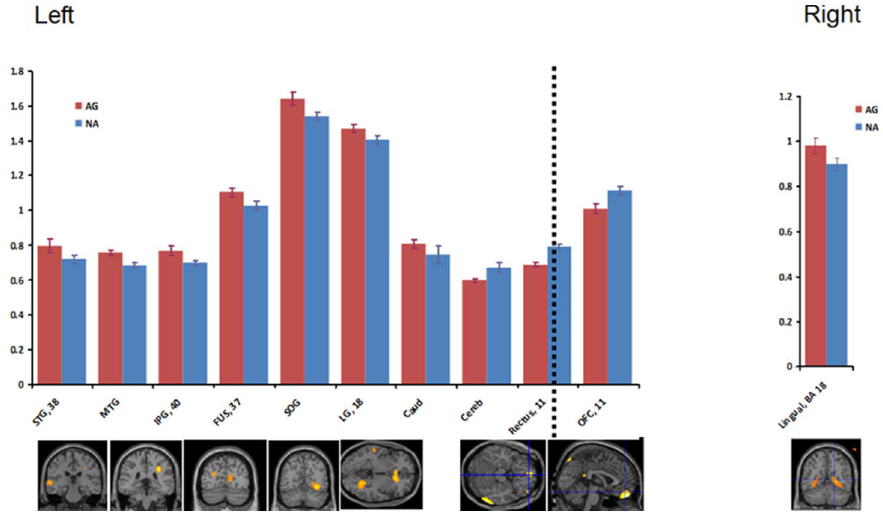
Figure 2. Glucose metabolism in response to media condition. Left panel: Relative glucose metabolism (Y-axis) in Ag (red) and Na (blue) in response to the violent media. On the left of the dotted line are results from Ag . Na contrast and on the right of the dotted line are results from the Ag , Na contrast. Right panel: Glucose metabolism results in response to the emotional media Ag . Na. There were no significant results for Ag , Na. Standard error is presented in the corresponding error bars.